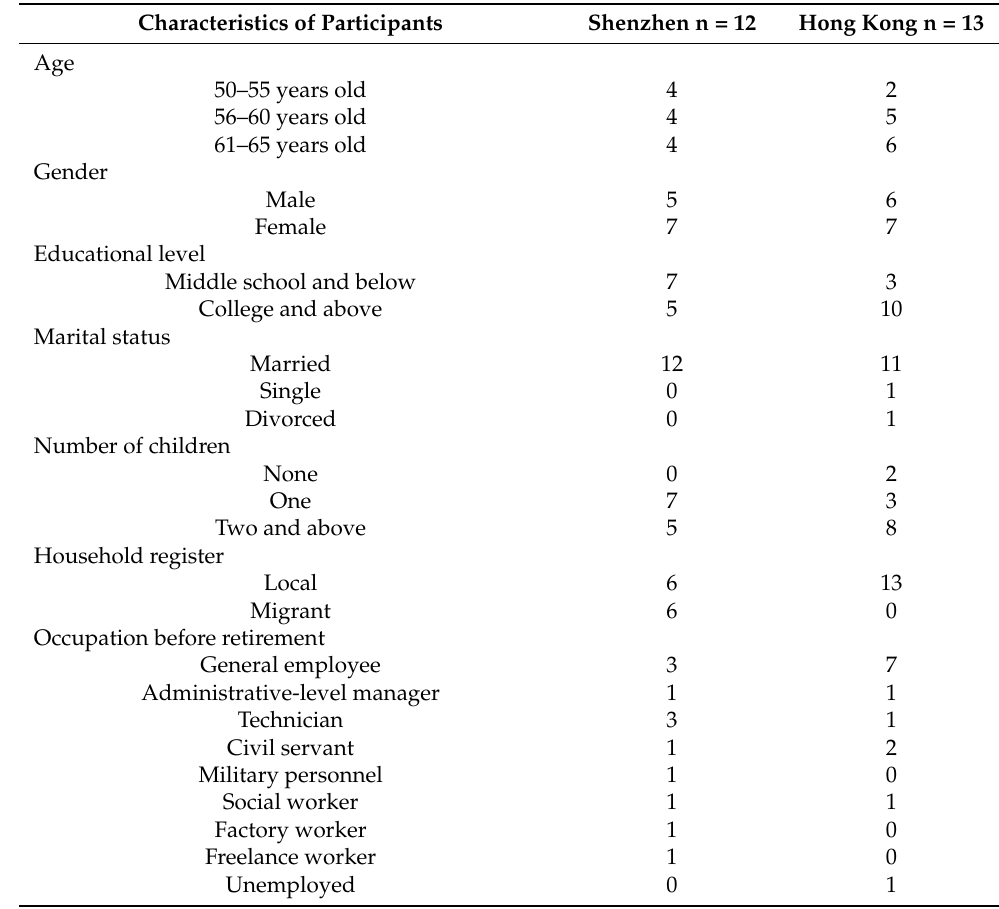
Table 1. Demographic profile of participants (n =